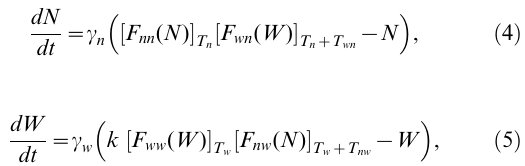
where T wn and T nw represent additional time delays resulting from the non-instantaneous nature of the interactions between the Wnt and the Notch pathways. We repeated the simulations in Figure 4A using this modified model, for many values of T wn and T nw . The results for T wn = T nw = 10 min are plotted in Figure 4B and animated in Movie S2. Observe that the dynamic behaviour of the whole cell set is very similar to that of simulations in Figure 4A. We repeated the simulations with T wn = T nw = 20, 30, 40 min and